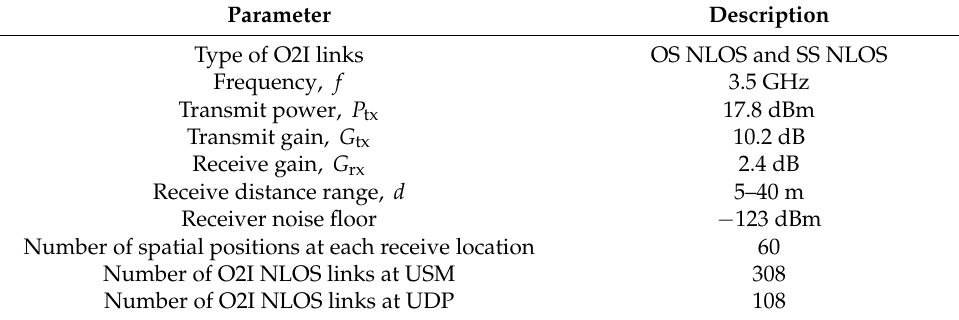
Table 3. Measurement